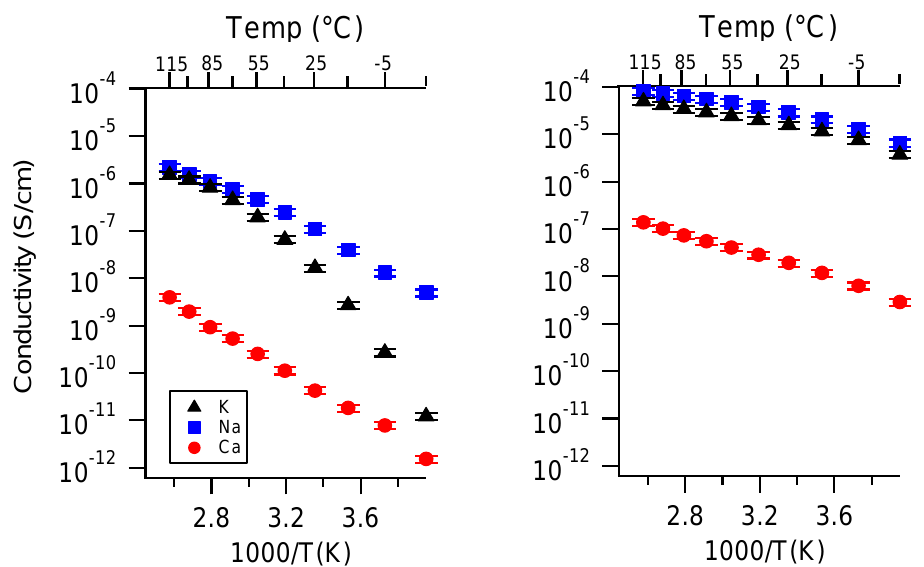
Figure A2. Conductivity as a function of cation for PEGDMA1000_med_SSM (left) and PTHFDA1000_med_STFSI (right) SIPEs swelled with DEG. Temperatures ranged from − 20 °C to 115 °C.